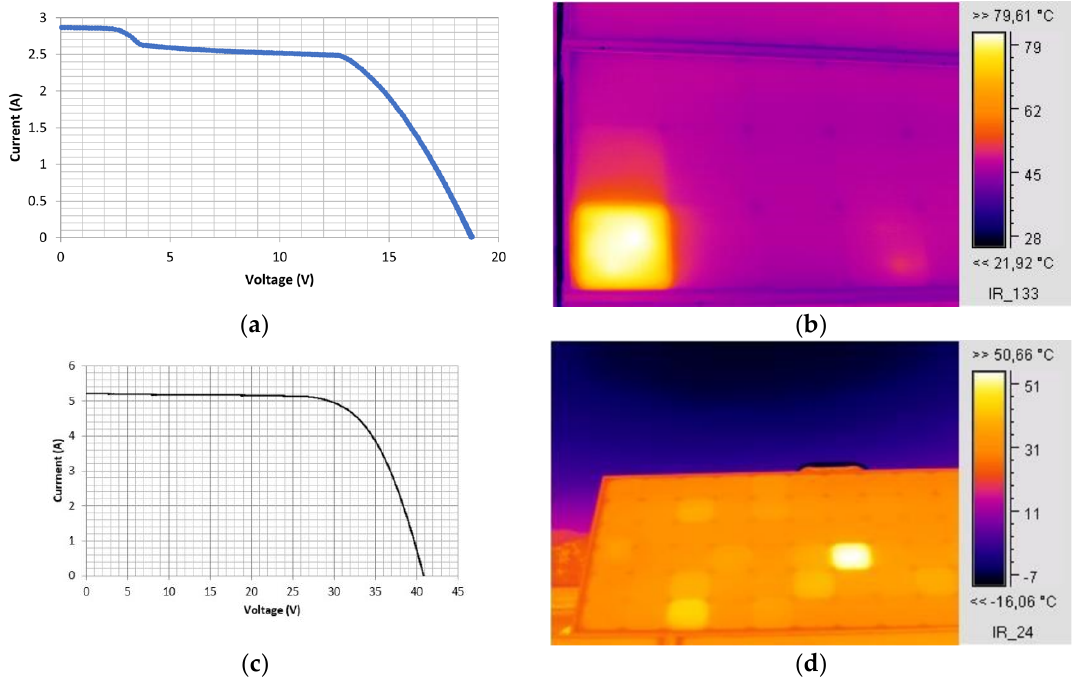
Figure 4. ( a ) The I–V characteristic and ( b ) IR thermography of an M55 module, operating for 24 years, with EVA browning in the bottom-left-corner cell. The affected cell exhibits increased temperature of around 34 ◦ C higher than neighbouring cells in the module. ( c ) I–V curve of a brand-new c-Si BIO175 module at I T = 899 W/m 2 , ( d ) IR image of the same module during operation. Milder thermal effects linked to current mismatch were also identified in new modules. The IR image of a brand-new c-Si BIO 175 W p under operation revealed a hot cell with T c over 15 ◦ C higher than the temperature of the neighbouring cells in the module (Figure 4d). This is attributed to localised imperfections at the production stage and may signal the onset of degradation. Figure